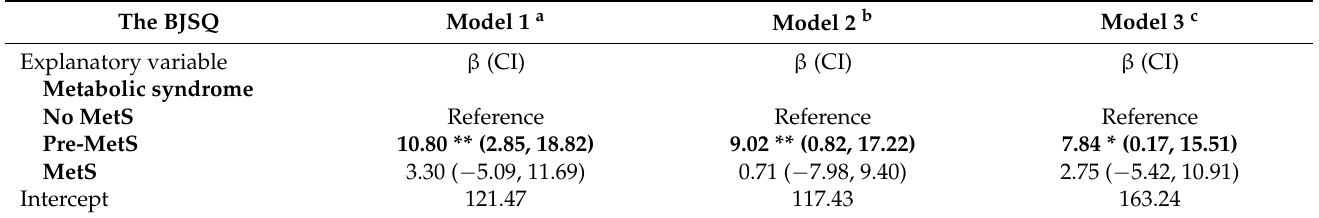
Table 2. Coefficients ( β ) and 95% confidence intervals for the association between metabolic syndrome and the Brief Job Stress Questionnaire score ( n = 167).